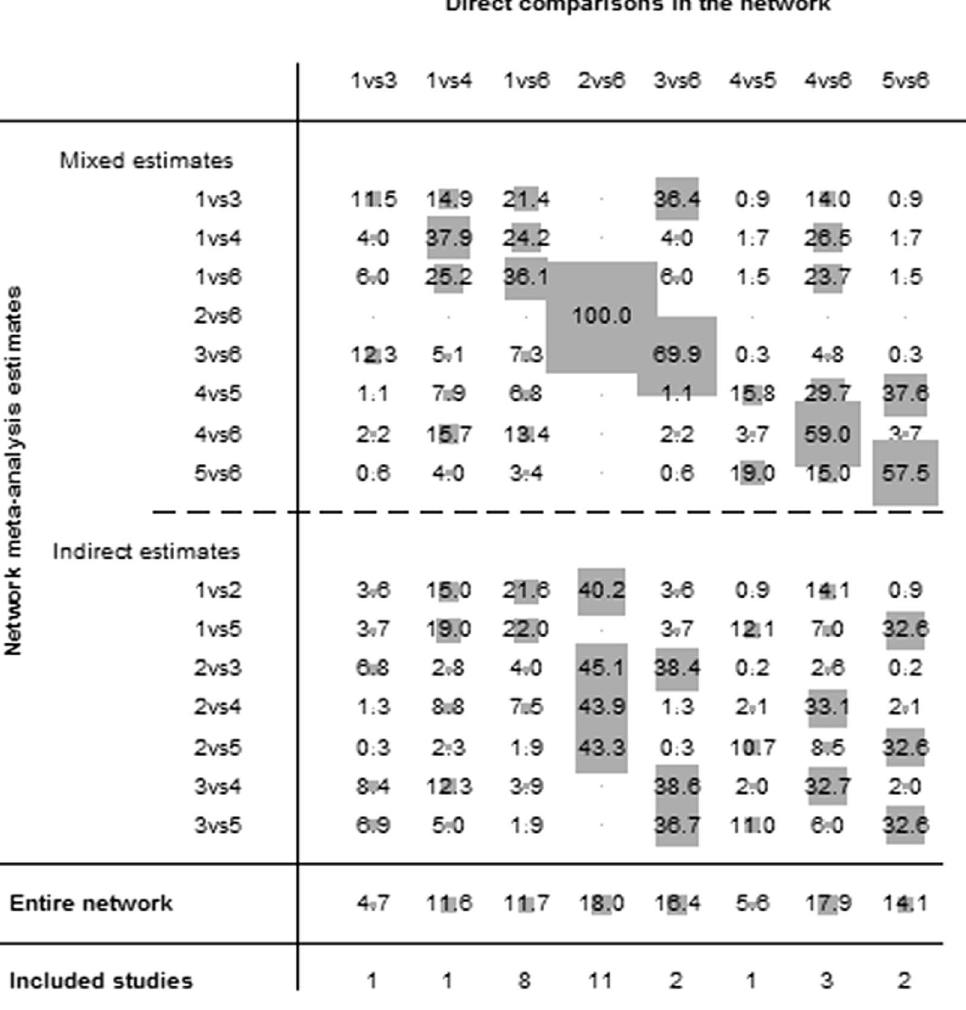
Figure 3. Contribution plot of the direct comparisons and the indirect comparisons. (1: neoadjuvant CT, 2: neoadjuvant CRT, 3: neoadjuvant RT, 4: adjuvant CT, 5: adjuvant CRT,